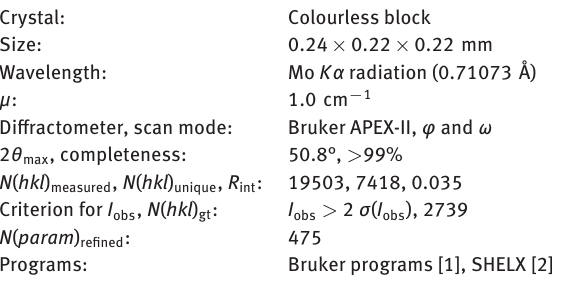
Table 1: Data collection and